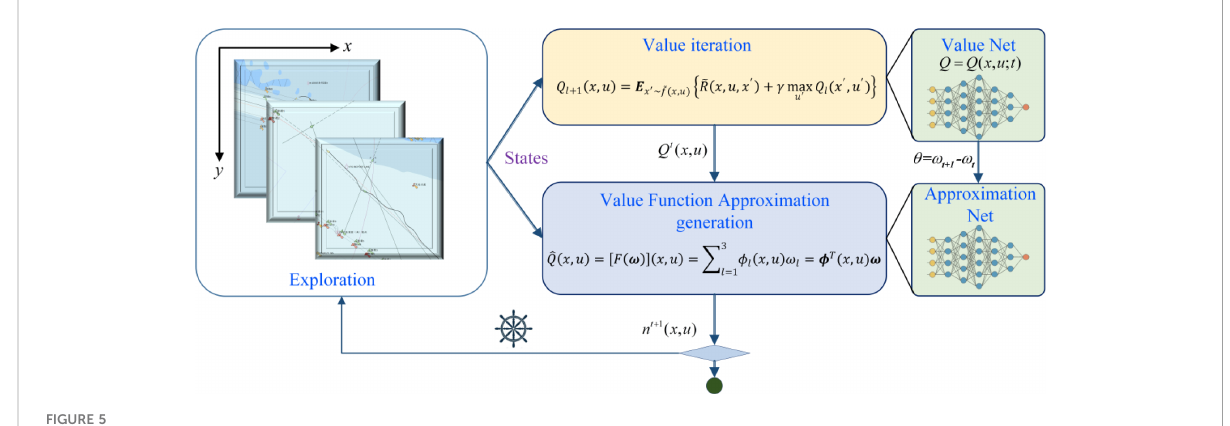
FIGURE 5 Q-valued function approximation learning algorithm